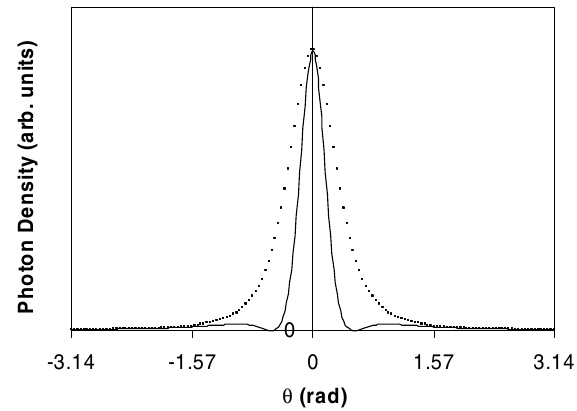
FIG. 4. Scattered photon density vs scattering angle ( (cid:24) ) from the z axis in the x - z plane (solid line) and the y - z plane (dotted line) for the case of a relativistic electron ( (cid:15) (cid:2) 2 ) traveling along the z axis and an x polarized photon incident along the negative z